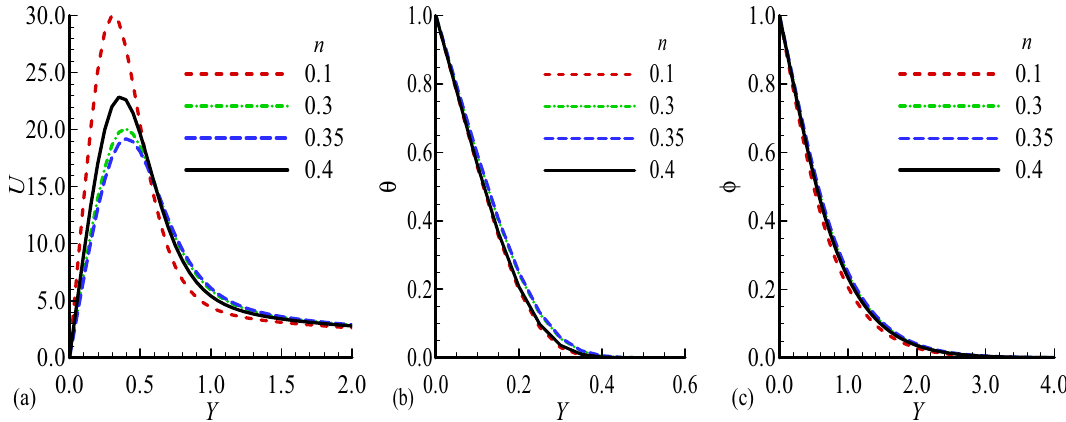
Figure 4. Dimensionless ( a ) Velocity U , ( b ) temperature θ and ( c ) mass distribution φ for different values of n = 0.1, 0.3, 0.35, 0.4 while E = 0.5 , γ = 0.1 , (cid:31) = 0.5 , β = 0.3 , (cid:31) T = 1.0 , (cid:31) c = 0.4 , Pr = 7.0, Sc = 0.2.